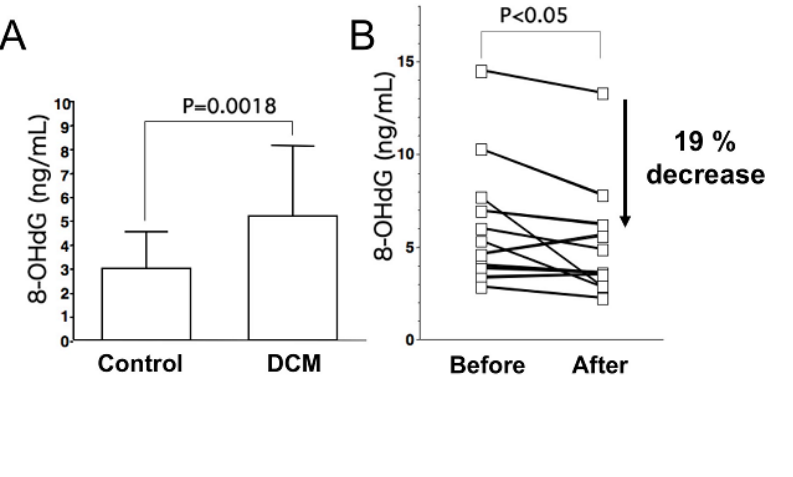
Figure 1. Elevated levels of oxidative DNA damage in serum and myocardium of patients with heart failure